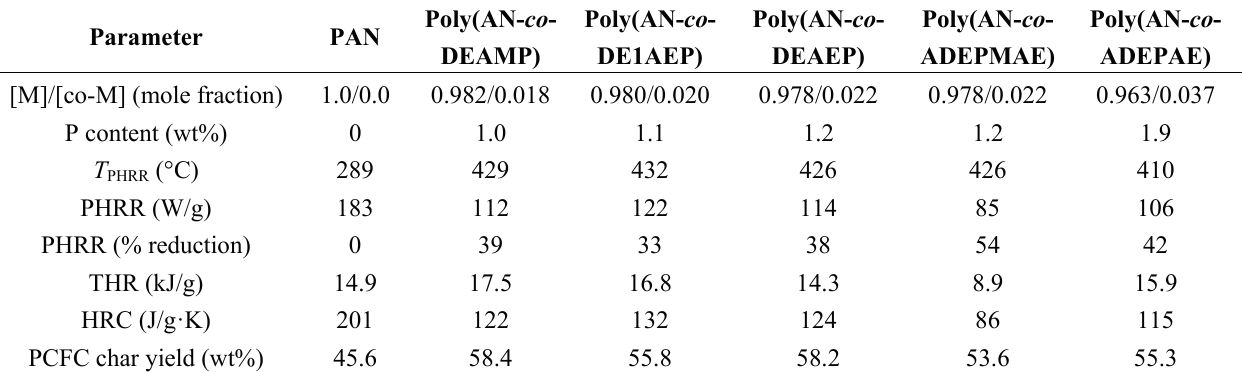
Table 5. PCFC parameters for AN-based polymeric